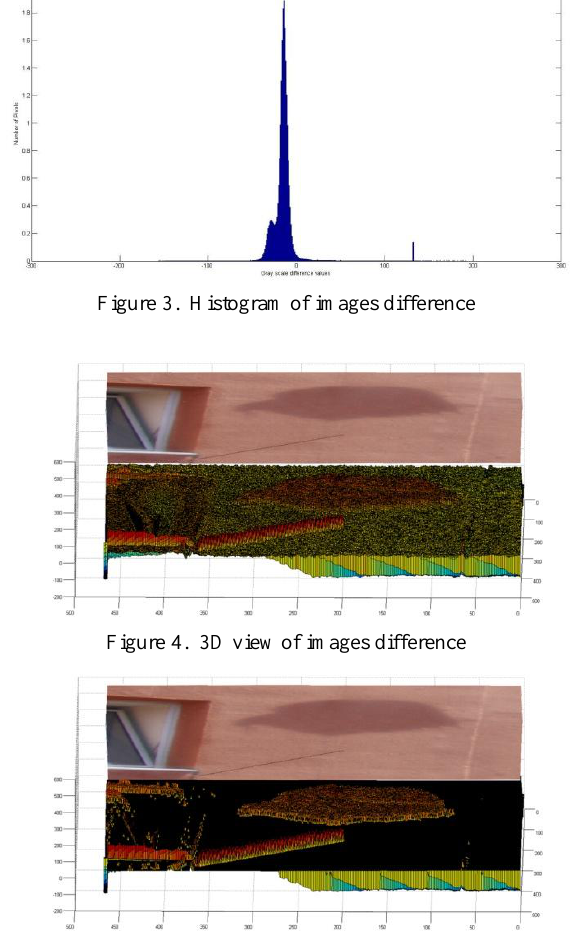
Figure 1. The base image